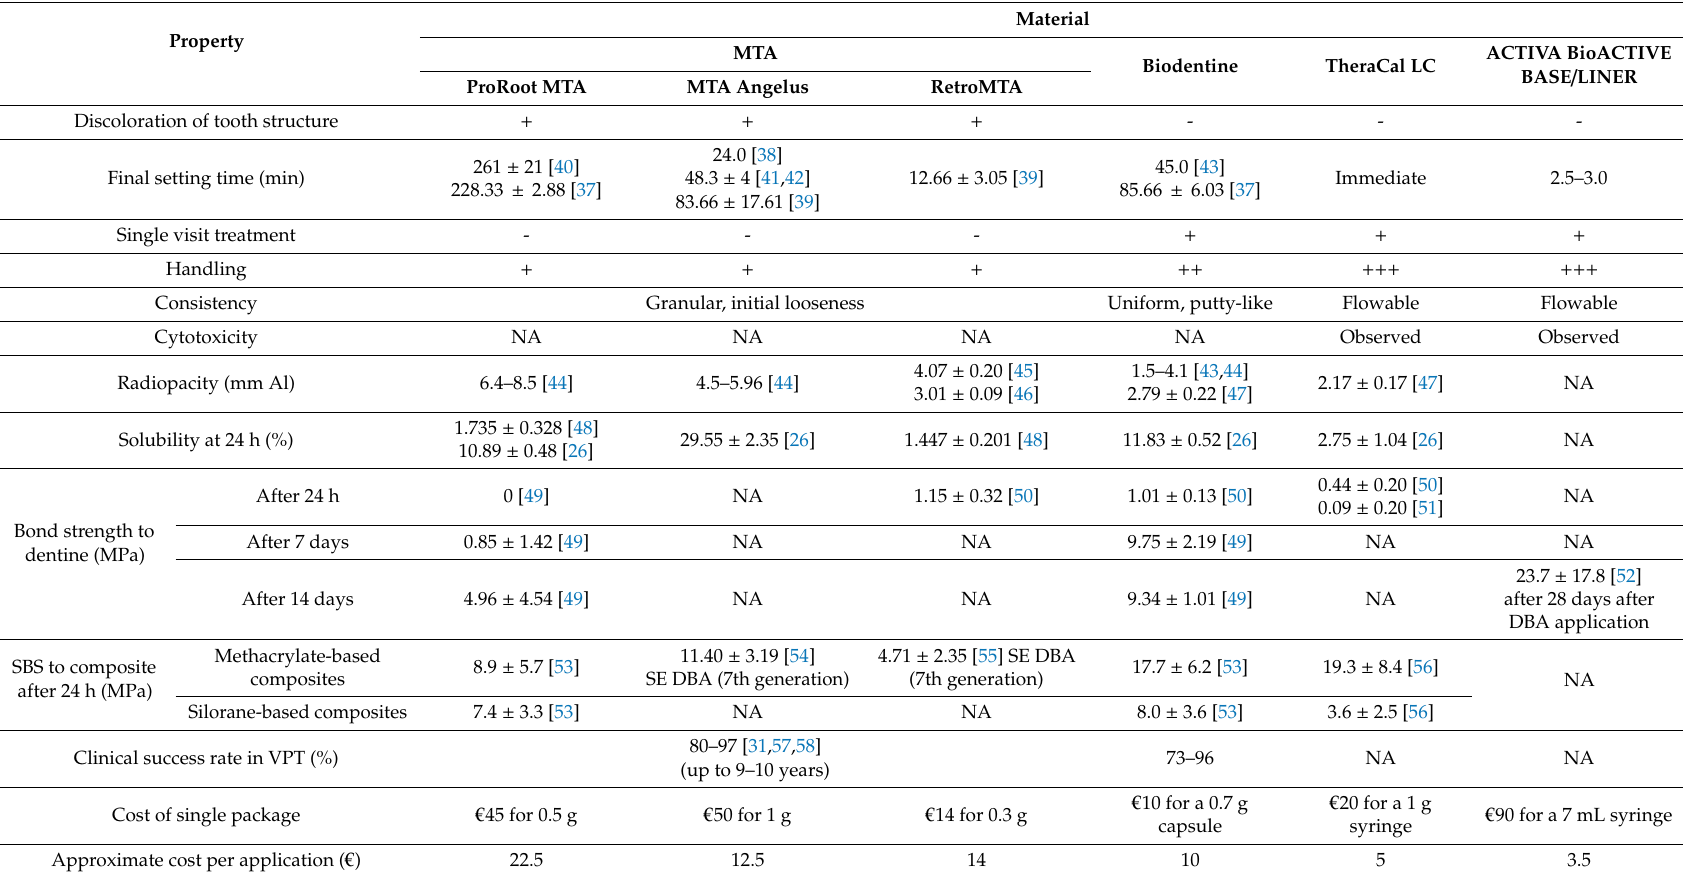
Table 2. Key properties of bio-inductive materials used in vital pulp treatment (VPT)—clinical manipulation and performance.